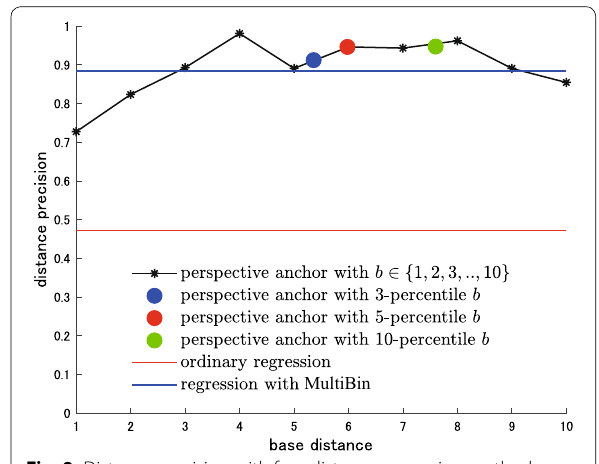
Fig. 9 Distance precision with four distance regression methods: ordinary regression, regression with MultiBin, regression